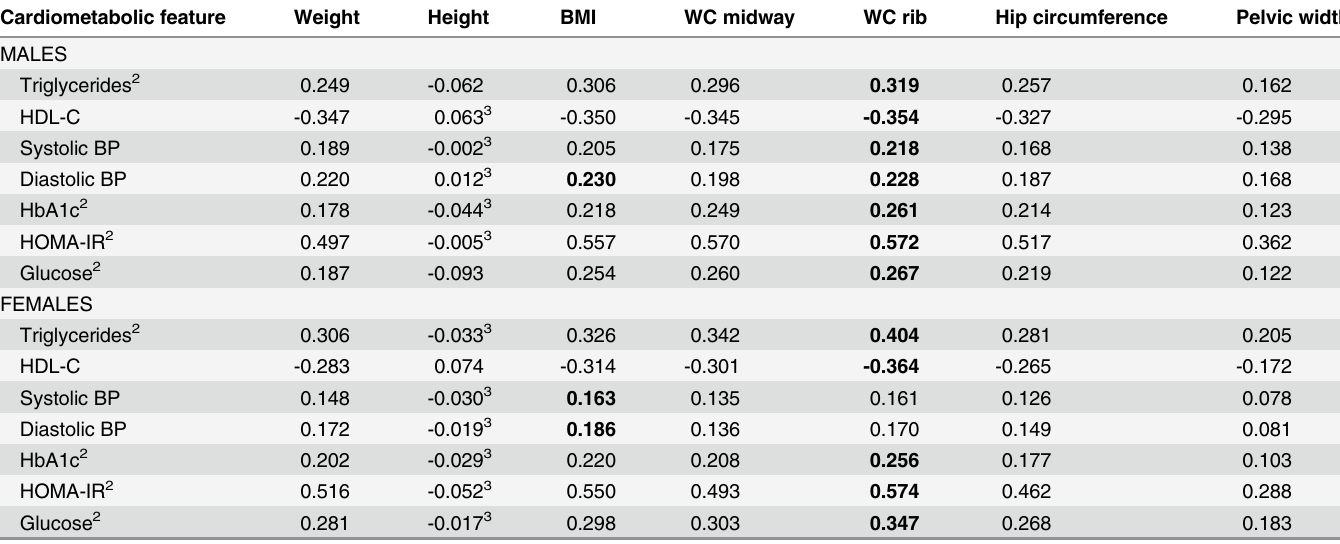
Table 2. Partial correlations 1 between anthropometric measurements and cardiometabolic variables, stratified by gender. Cardiometabolic